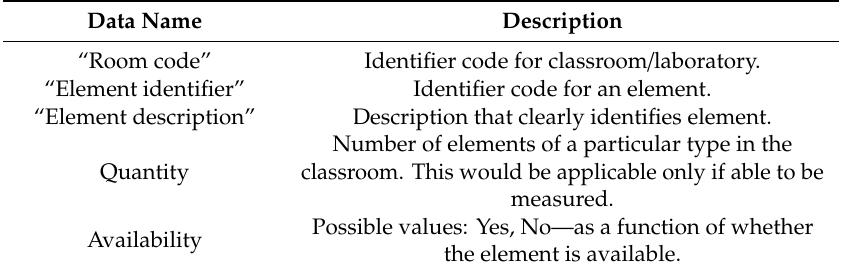
Table 2. Characteristics Spaces Data